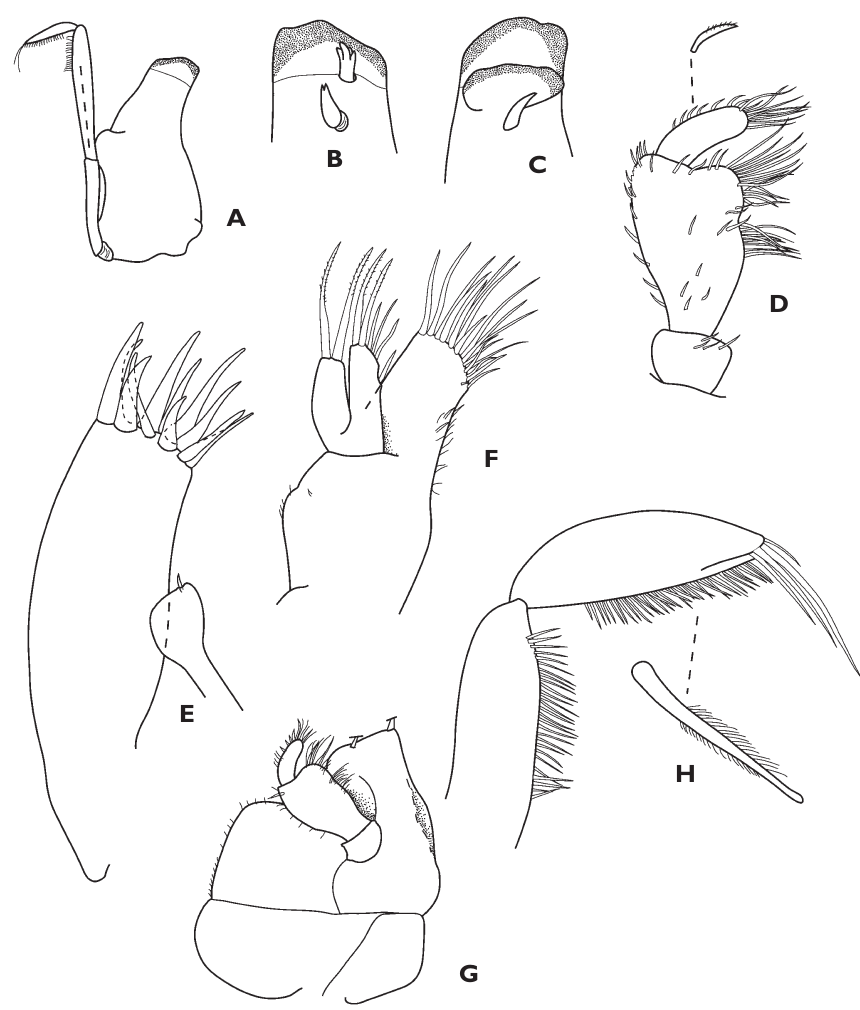
Figure 10. Myopiarolis koro sp. n. Female paratype, except D, holotype. A right mandible B right mandible C left mandible D maxilliped palp E maxillule F maxilla G maxilliped H mandible palp, distal article 2 and article